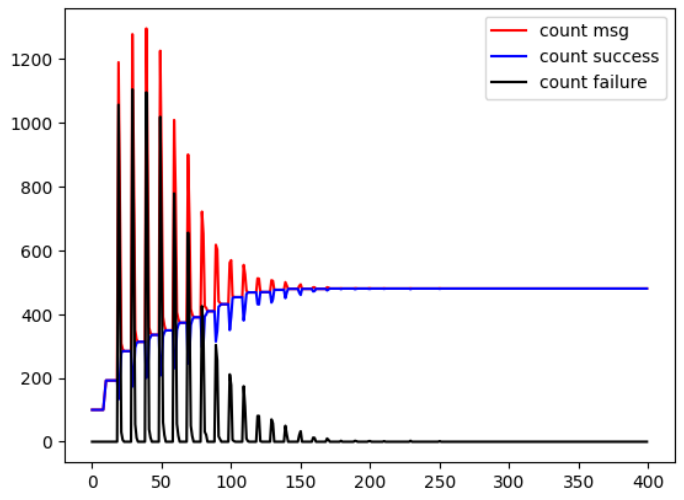
Figure 13. Communication result in each frame for network consisting of 100